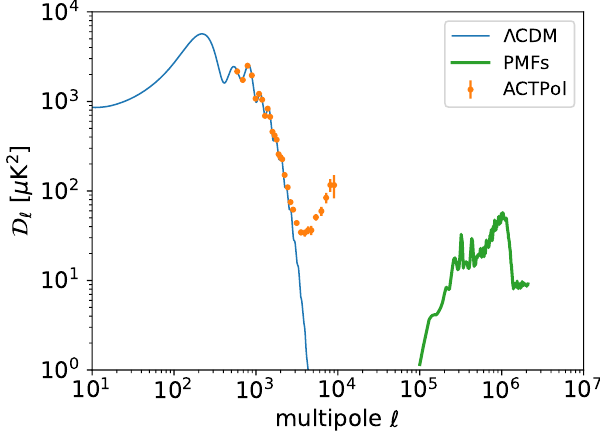
Figure 2. CMB temperature power spectrum for the multipole 10 < (cid:96) < 10 7 . We plot the resultant angular power spectrum caused by the tSZ effect from the PMFs with the thick green line. The result is obtained by integrating Equation (15) from z = 1000 to z = 10, and the parameters for the PMFs are fixed to B n = 0.5 nG and n B = − 1. The primary component of the CMB angular power spectrum predicted from the Λ CDM cosmology and the observational data with the Atacama Cosmology Telescope (two-season ACTPol) [19] are also shown with the blue solid line and the orange dots with error bars,